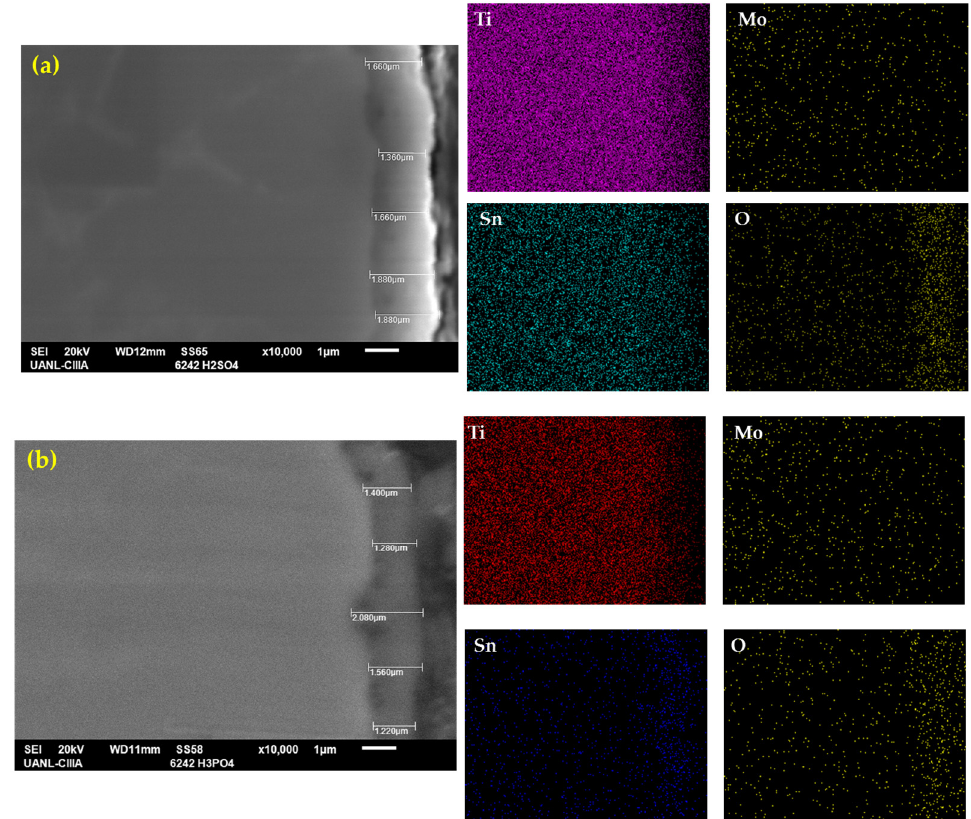
Figure 3. SEM-SEI of the cross-section of Ti-6Al-2Sn-4Zr-2Mo in ( a ) H 2 SO 4 and ( b ) H 3 PO 4 ; the elemental mapping by SEM identified Ti, Mo, Sn, and O.